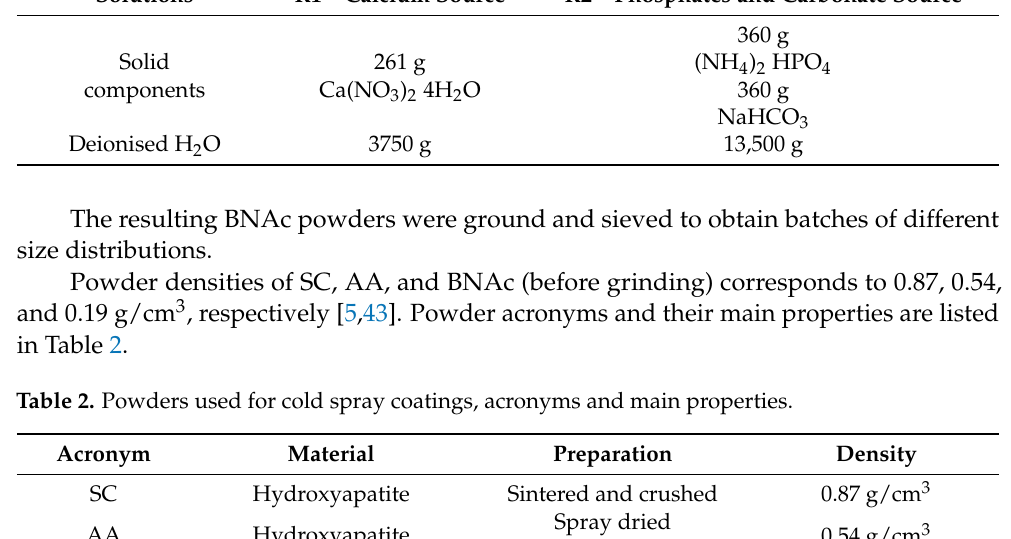
Table 1. Biomimetic apatite powder synthesis procedure. Solutions